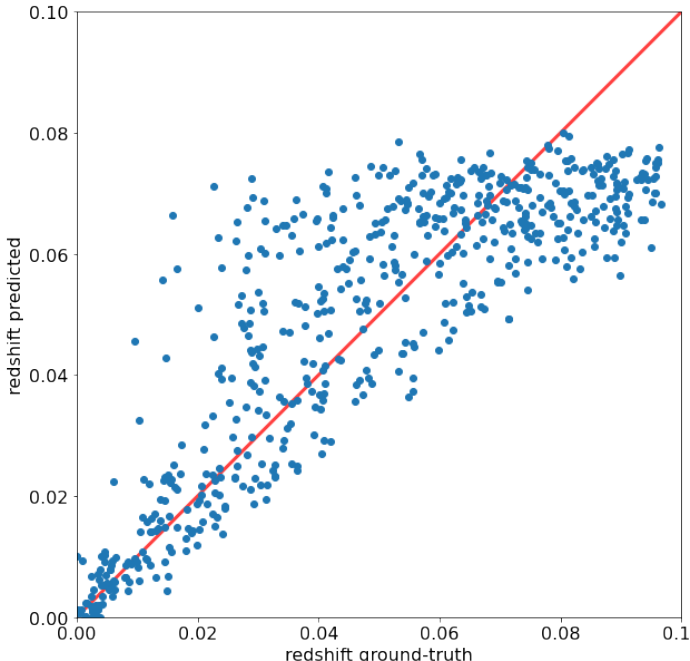
Figure 6. Predicted redshifts versus the true redshifts of the simulated sources (blue points); the red solid line represents the expectations in the case that the predicted redshifts exactly match the true redshifts.